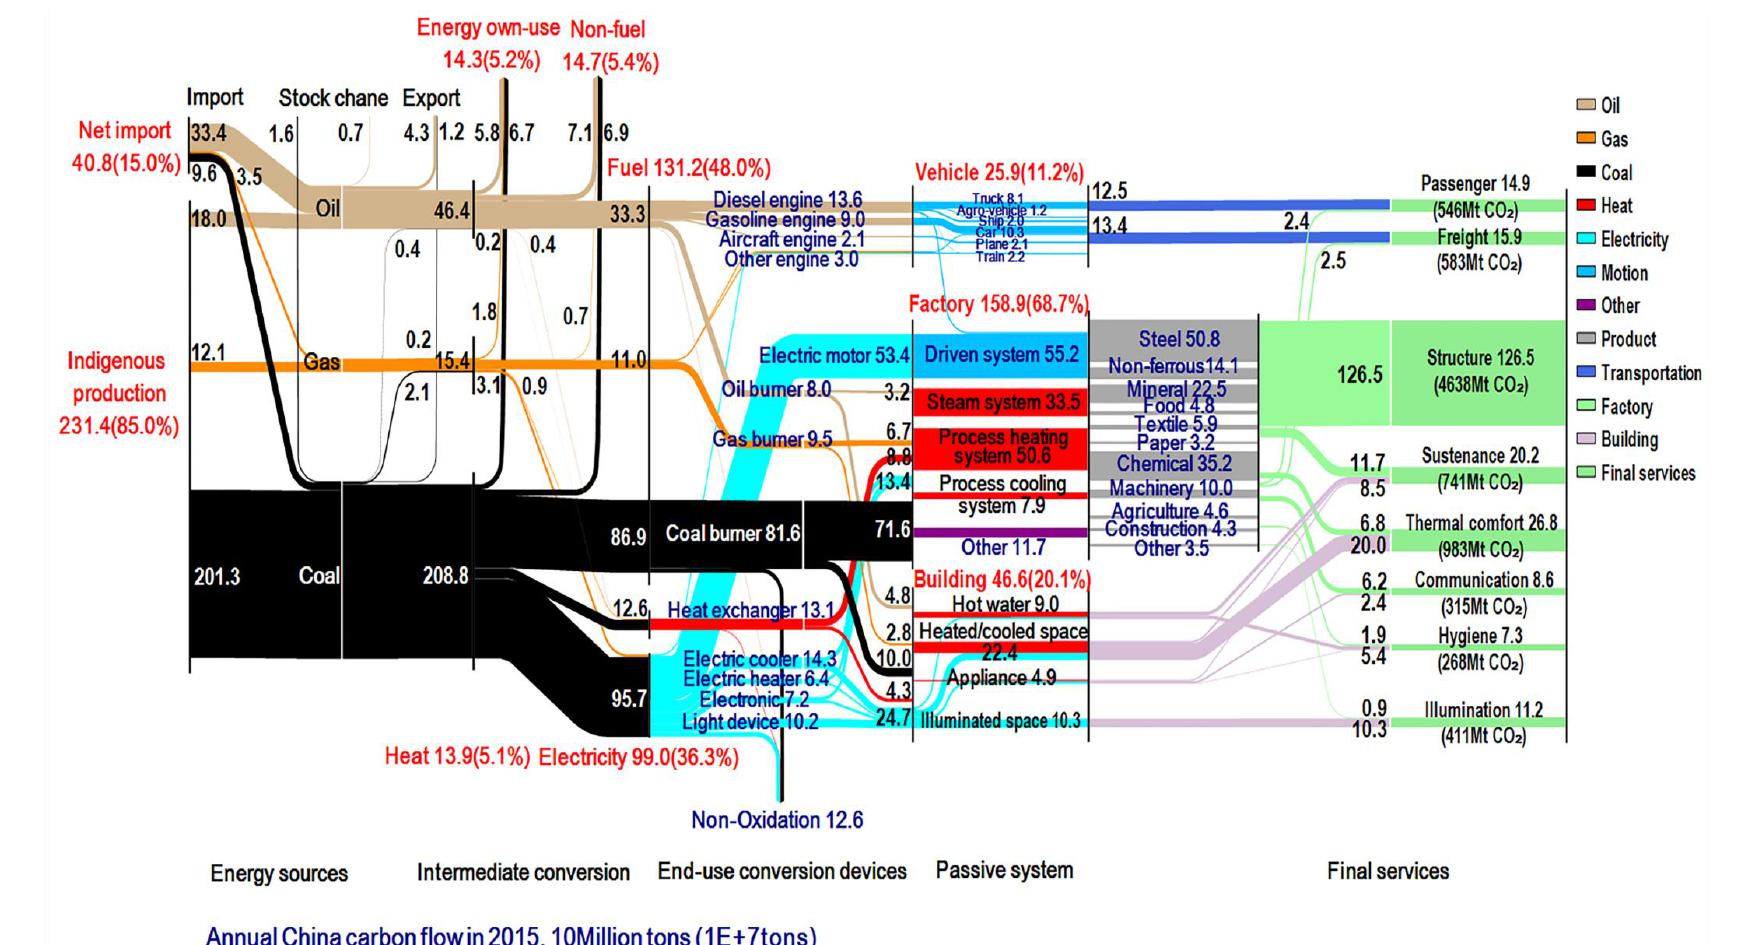
Figure 4. China’s energy-related carbon flow diagram in 2015, unit in 10 Mt C (10 7 tons C).